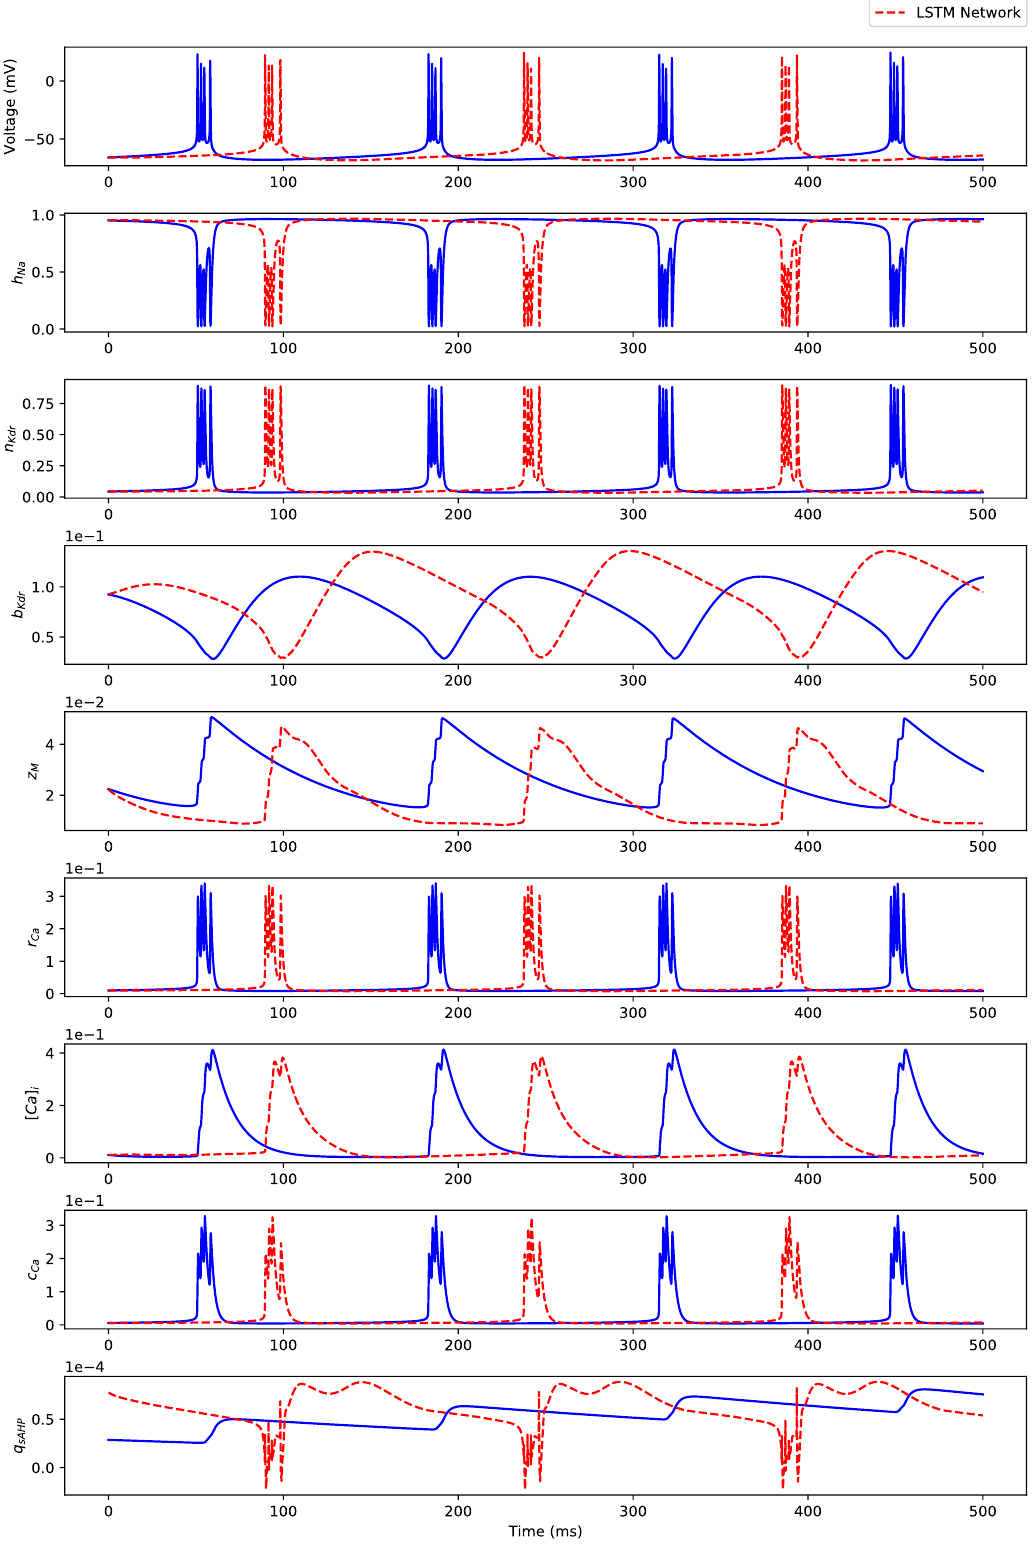
Figure A11. Comparison between the Hodgkin-Huxley model (“HH Model”) states’ dynamics and the iterative predictions of states’ dynamics using the 1 timestep predictive horizon-based deep LSTM neural network (“LSTM Network”) in response to I = 0.5